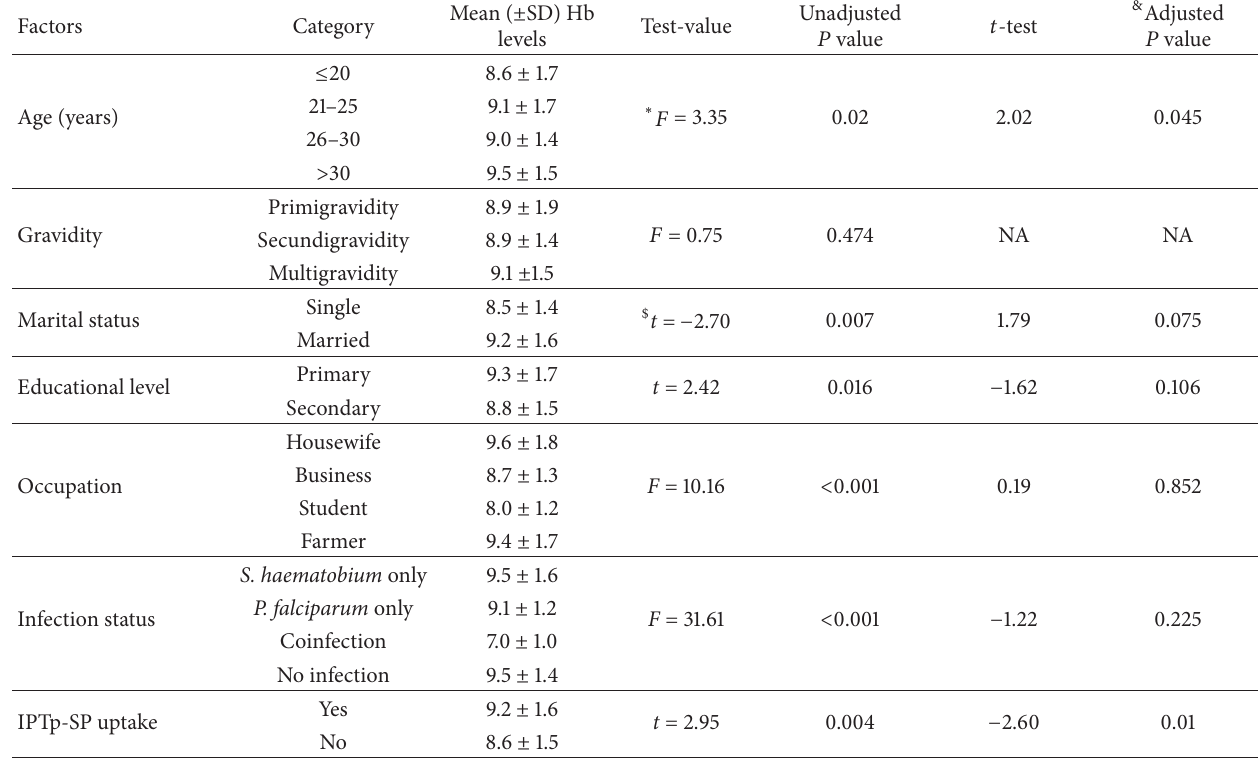
Table 4: Factors associated with mean ( ± SD) haemoglobin levels among pregnant women in Munyenge Health Area. Factors